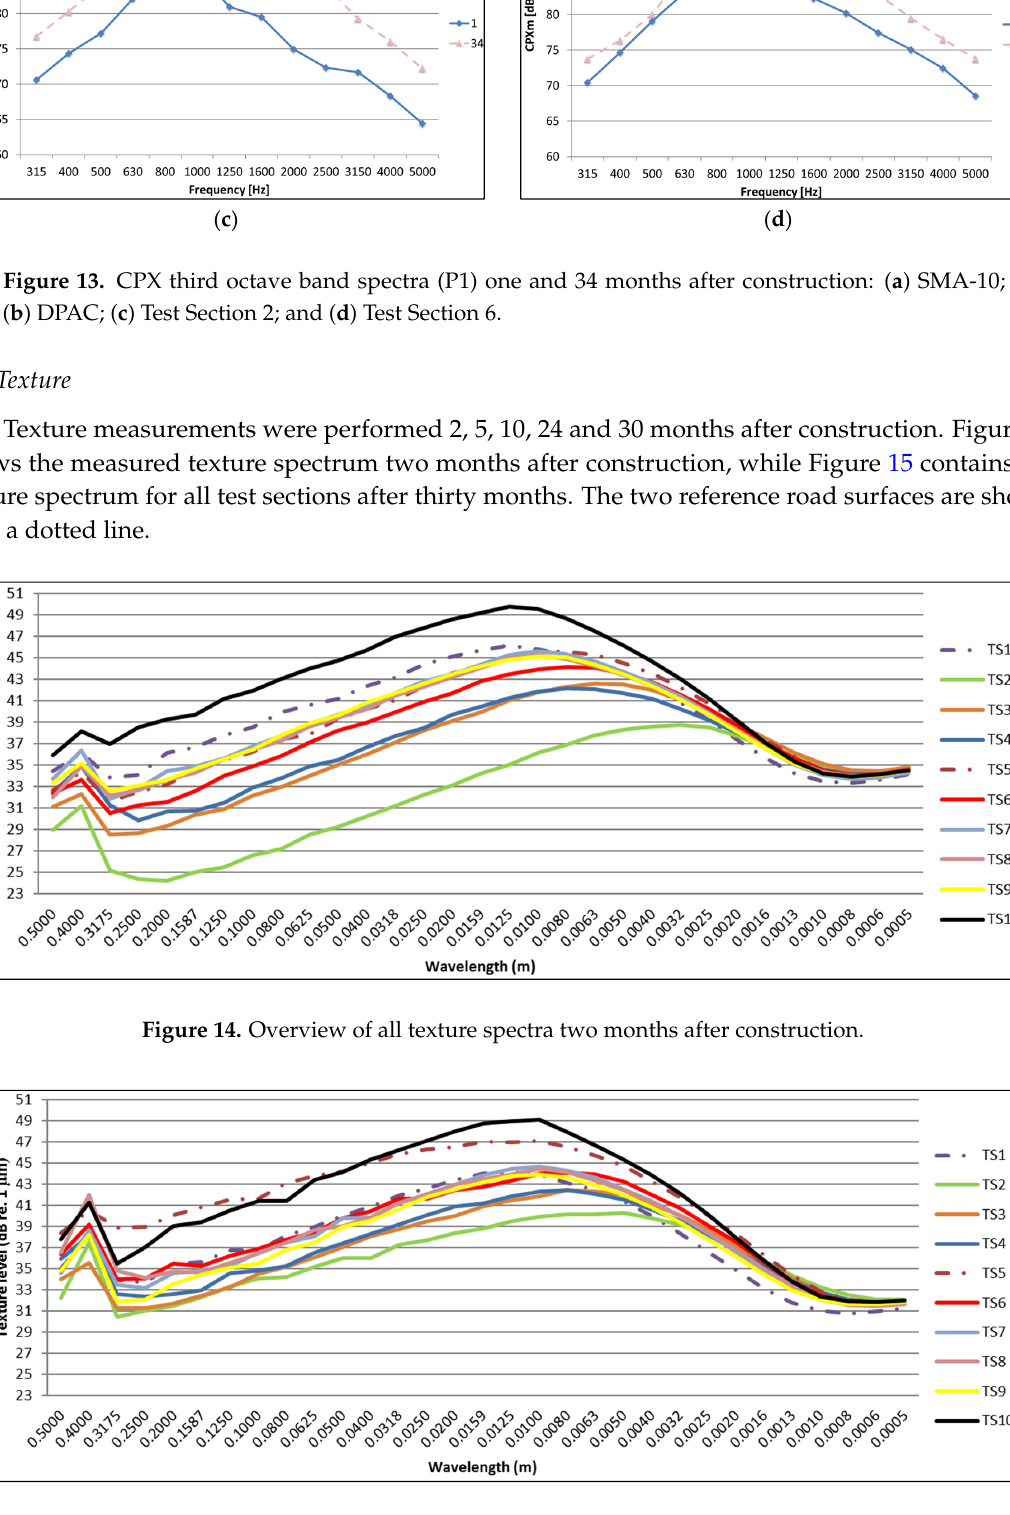
Figure 15. Overview of all texture spectra thirty months after construction.